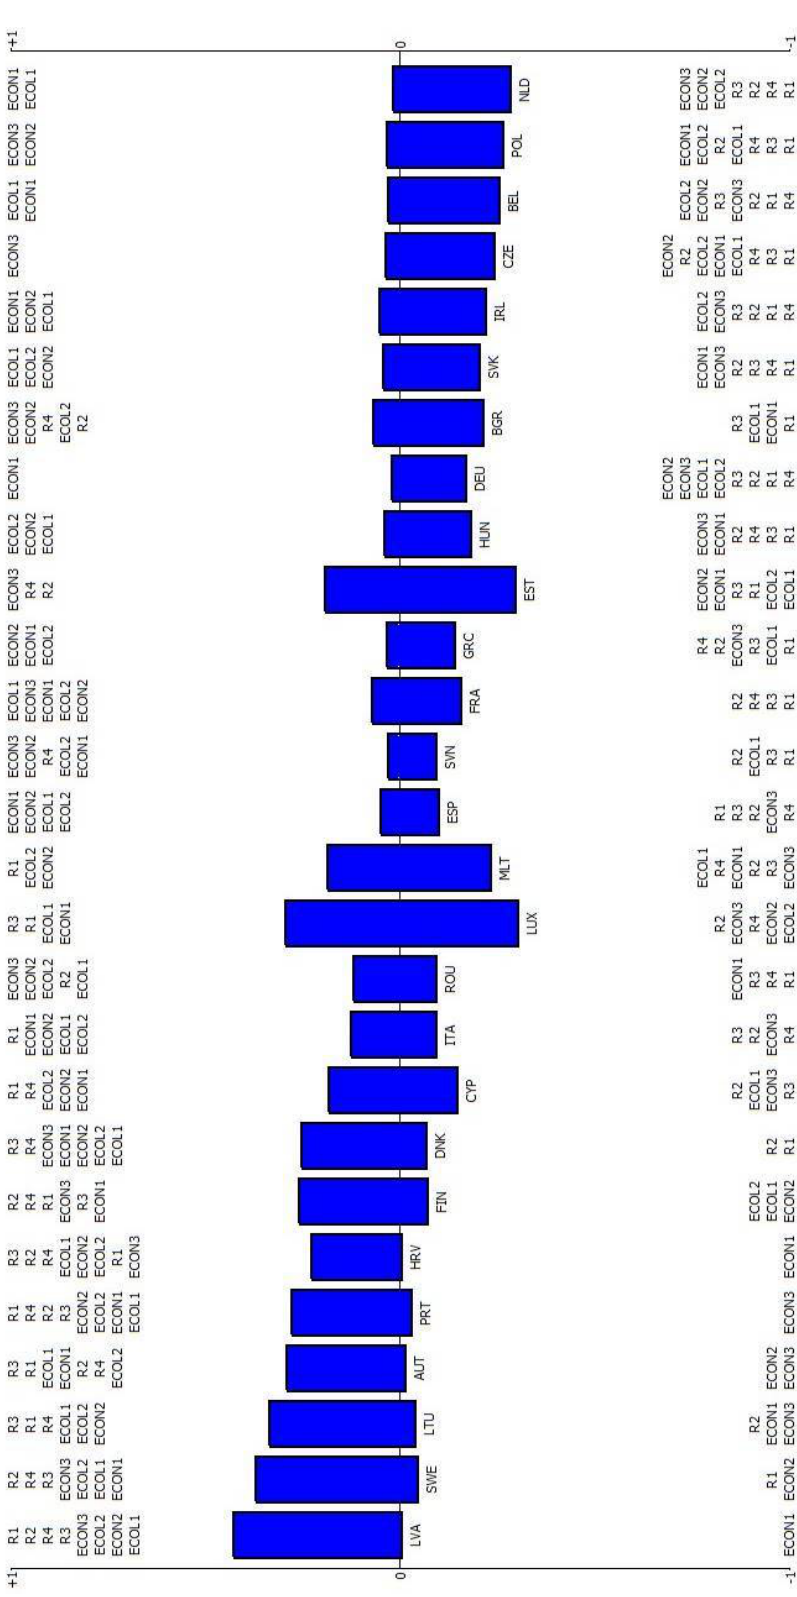
Figure A2. Rainbow diagram for 2018.